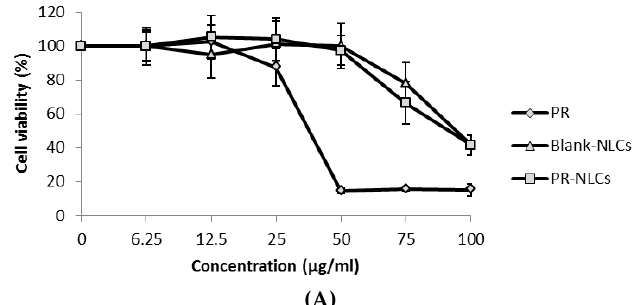
Figure 8. In vitro release profiles of PR solution and PR-NLCs ( n = 3, mean ± SD).